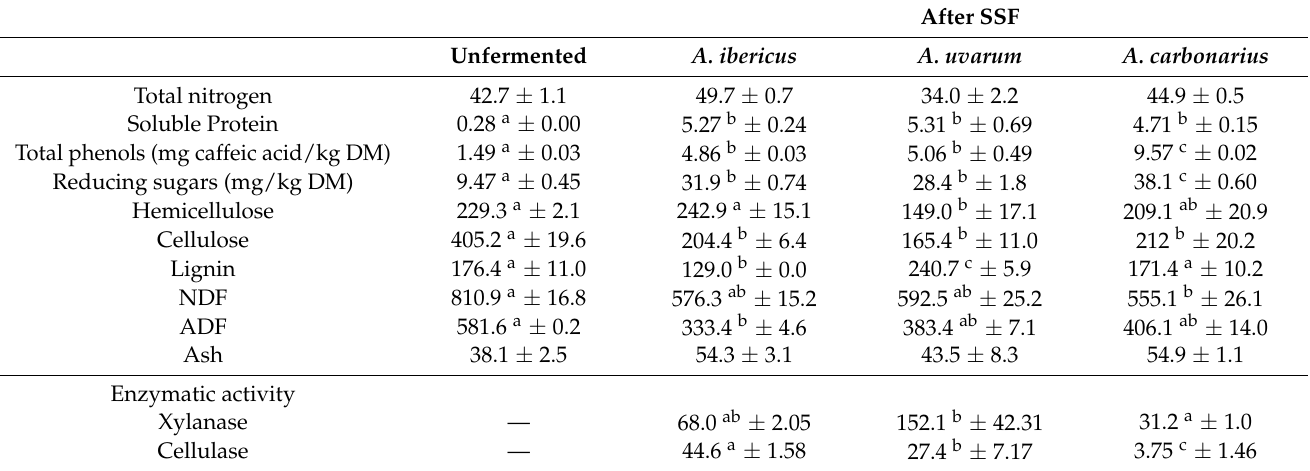
Table 3. Chemical composition (g/kg DM) and enzymatic activity (U/g) of distiller’s dried grains with solubles (DDGS) before (unfermented) and after solid-state fermentation (SSF) with Aspergillus ibericus , Aspergillus uvarum , and Aspergillus carbonarius . After SSF Unfermented